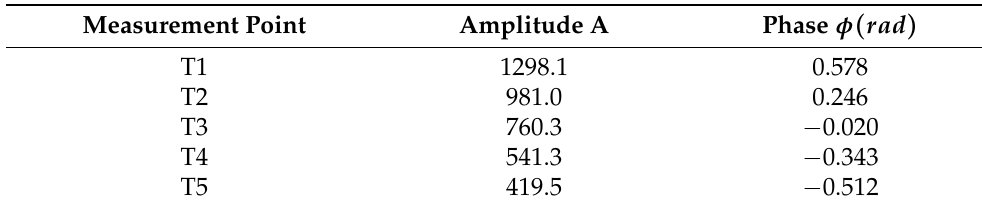
Table 3. Amplitude and phase for the component within a period of 24 h for August 2019 at measurement points.